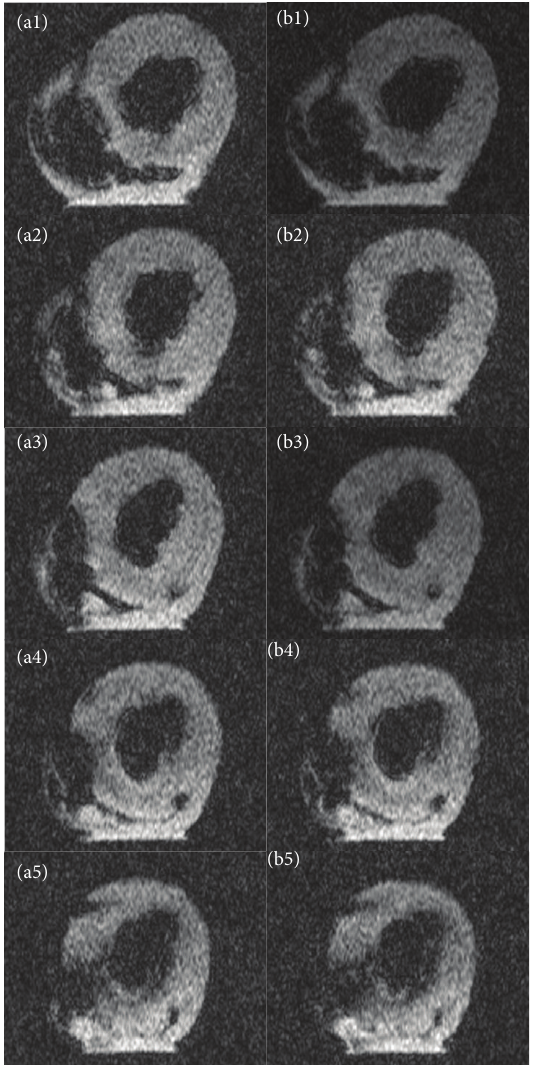
Figure 6: MRI images of porcine myocardium before and after unlabeled MSC injection. T2 ∗ -images of porcine myocardium before injection (a1–a5) and after injection (b1–b5) of unlabeled MSCs. Unlabeled cells cannot be identified. MSCs: mesenchymal stromal cells. USPIO: ultrasmall superparamagnetic iron-oxide.